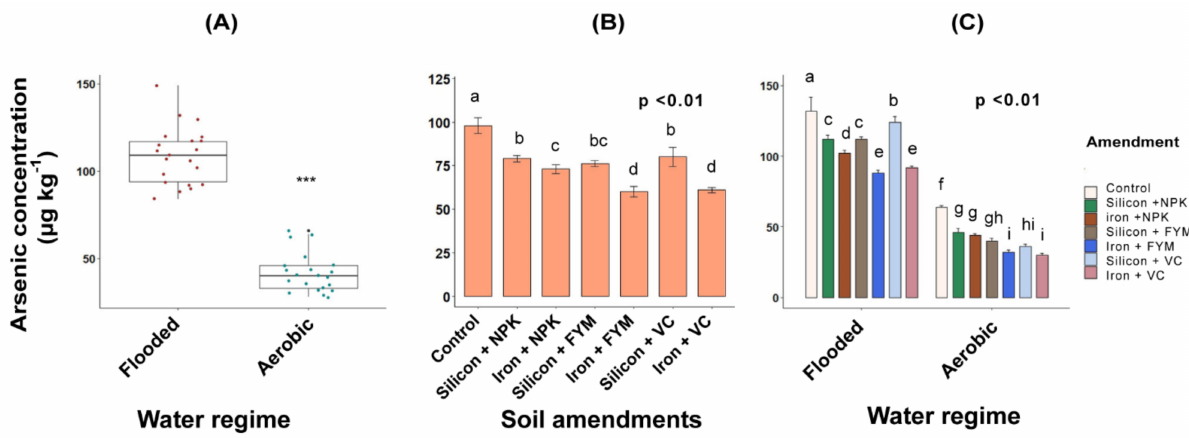
Figure 1. Total As concentration in rice grain in terms of water regime variation ( A ); soil amendment application ( B ); and interaction between water regime and amendment ( C ). Different letters indicate significant differences between treatments from Fisher’s LSD test ( p < 0.05); *** indicates significance level at p <